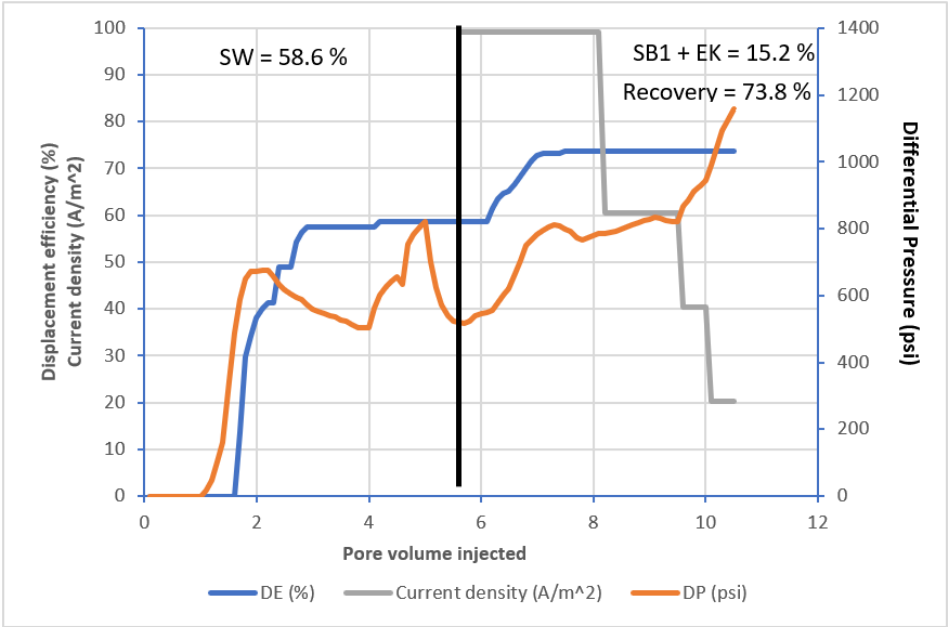
∆ P), Current Density vs. Pore Volume Injected for CF5. Figure 7. DE, DP (ΔP), Current Density vs. Pore Volume Injected for CF5. Figure 7. DE, DP ( CF6